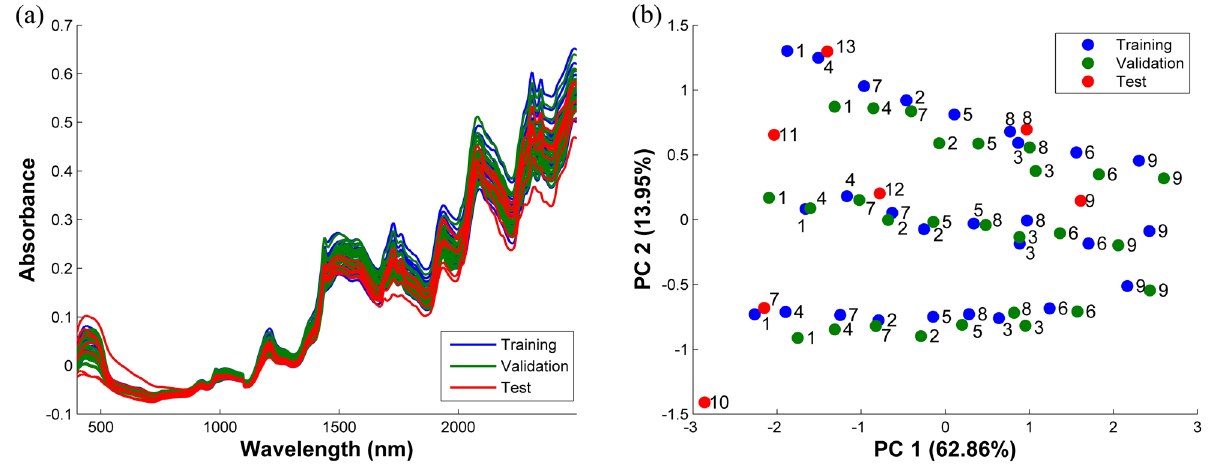
Figure 1. ( a ) NIR spectra of the studied milk samples (powder) and ( b ) PCA score plot of the corresponding NIR spectral data.